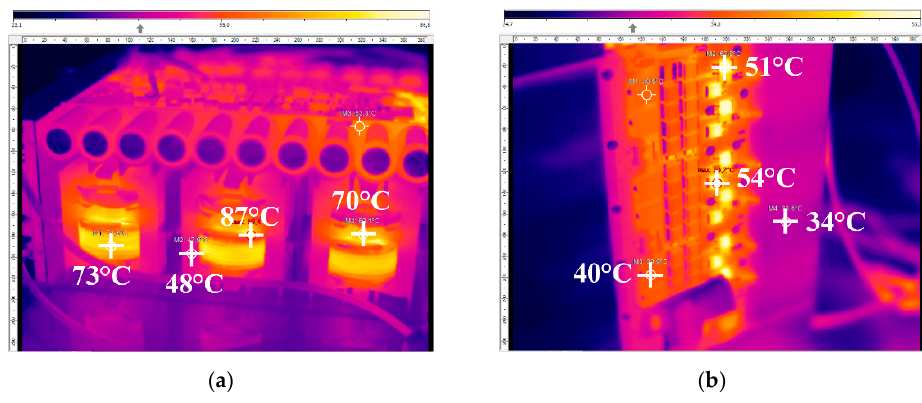
Figure 30. Thermal image of the prototype operating at full load. ( a ) View on hf transformers; ( b ) view on secondary-side rectifier. Table 9. Comparison between the proposed portable off-board charger and other state-of-the-art galvanically isolated on-board chargers.